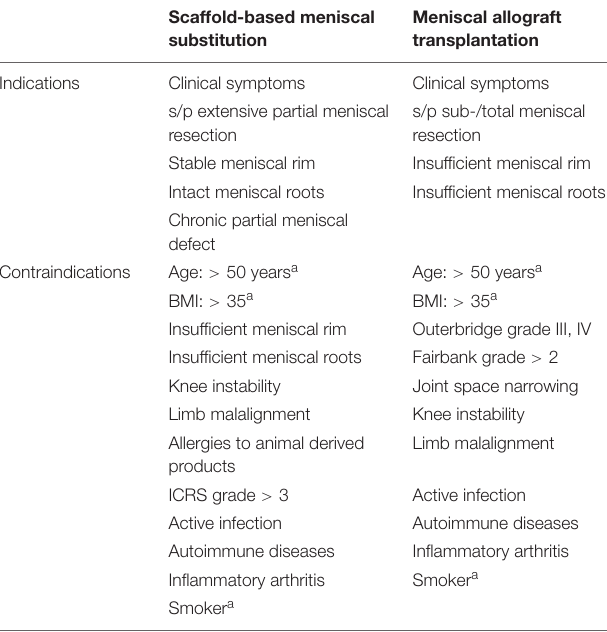
TABLE 3 | Indications and contraindications for scaffold-based meniscal substitutes and meniscal allograft transplantation. Scaffold-based meniscal